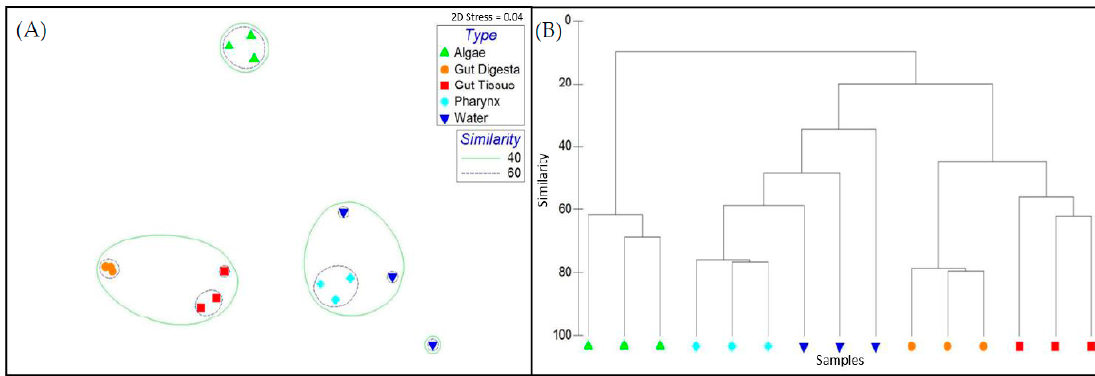
Figure 5. Beta diversity analysis of microbial communities observed across all samples in the study using Bray–Curtis similarity metrics determined for the rarefied OTU table. ( A ) A 2D multidimensional scale (MDS) plot analysis was performed to show sample cluster patterns based on observed OTUs, with a 40% and 60% Bray-Curtis similarity overlay, and the stress value (2D Stress = 0.04) was indicated. ( B ) Dendrogram analysis was also performed and each sample’s cluster patterns were based on group average. The OTU table was pretreated via standardization by the total and log transformation prior to Bray-Curtis analysis. Figure legends are shown in the 2D MDS plot. Data was generated and plotted through PRIMER-6 software (Primer-E Ltd, Plymouth Marine Laboratory, Plymouth UK, v6.1.2).